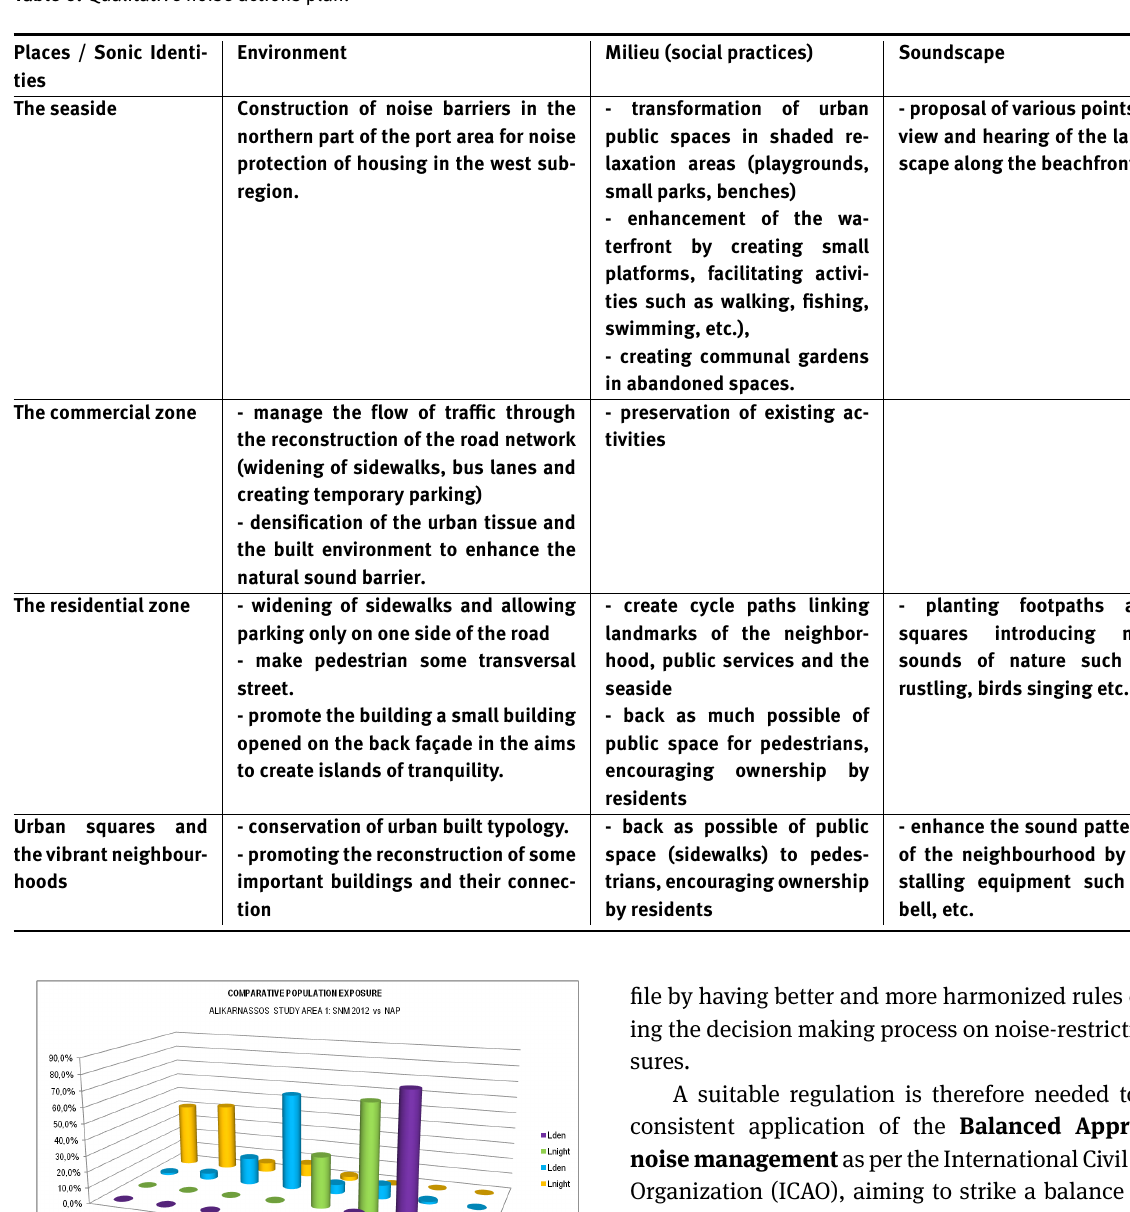
Table 6. Qualitative noise actions plan.